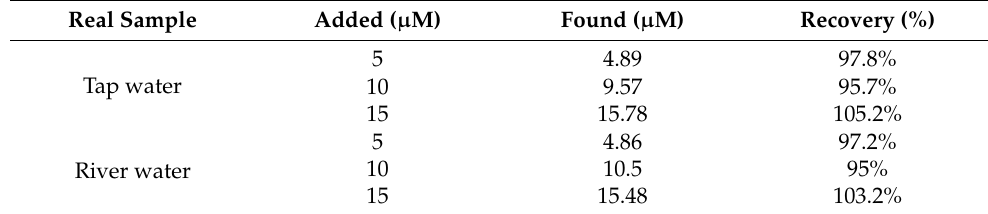
Figure 9. ( A ) AuNPs/MXene/ERGO/GCE detection nitrite in 8 samples with the same concentration. ( B ) The test of five AuNPs/MXene/ERGO/GCE in the same sample. Table 2. Determination of nitrite in water samples (n =